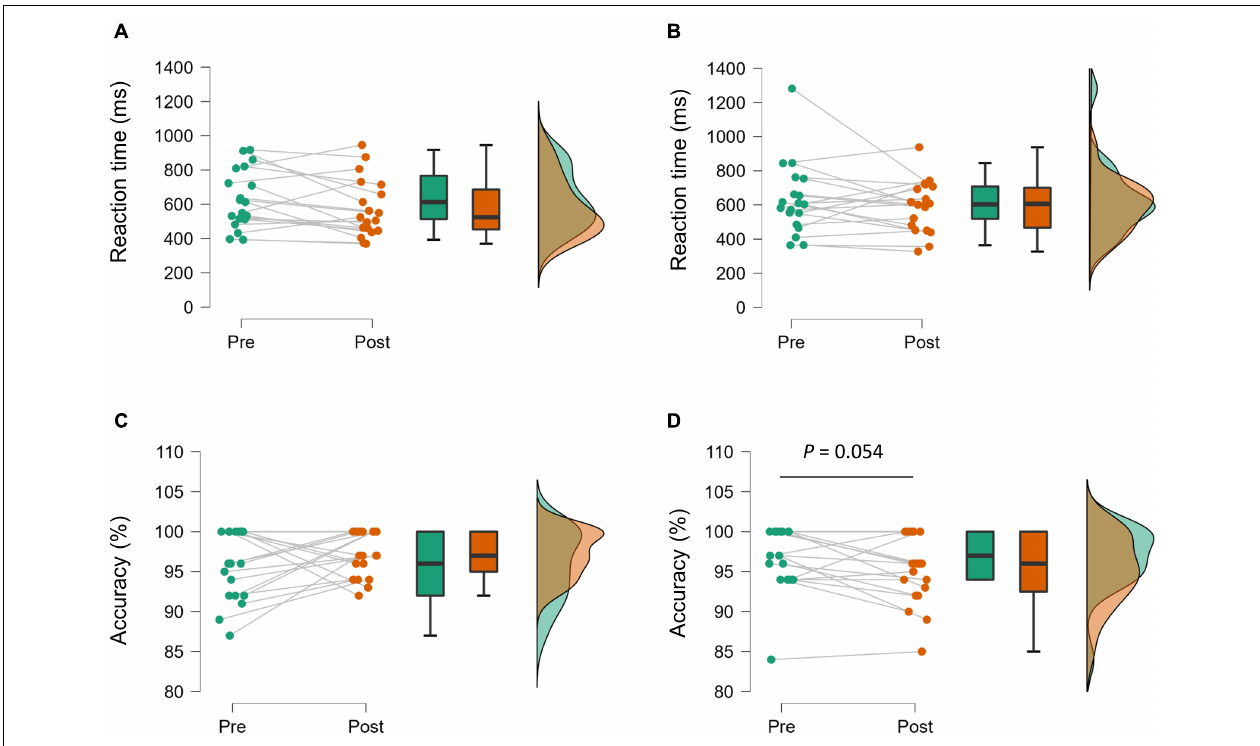
FIGURE 1 | Raincloud plots showing the distribution of reaction time [ (A) aerobic condition, (B) resistance condition] and accuracy of the Go/No-Go task [ (C) aerobic condition, (D) resistance condition]. Plots and lines represent individual data (left). The lower and upper hinges on the boxplots represent the first and third quartile with the median (center). Illustration of data distribution